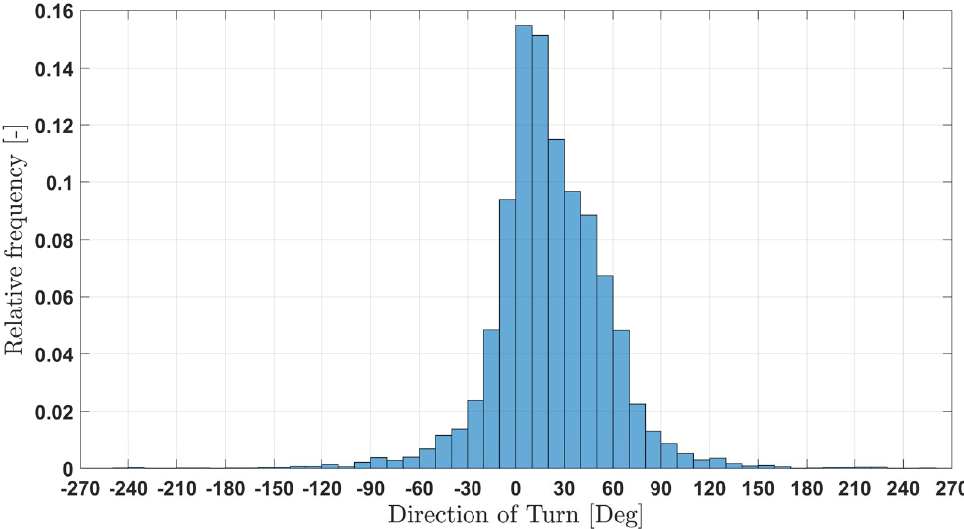
Figure 2. Relative Frequency distribution of wind direction rotation with altitude for the altitude interval of 40m to the maximum altitude of the LLJ for rotations to the left ( n = 1460) and rotations to the right ( n = 5288) at the Braunschweig site.